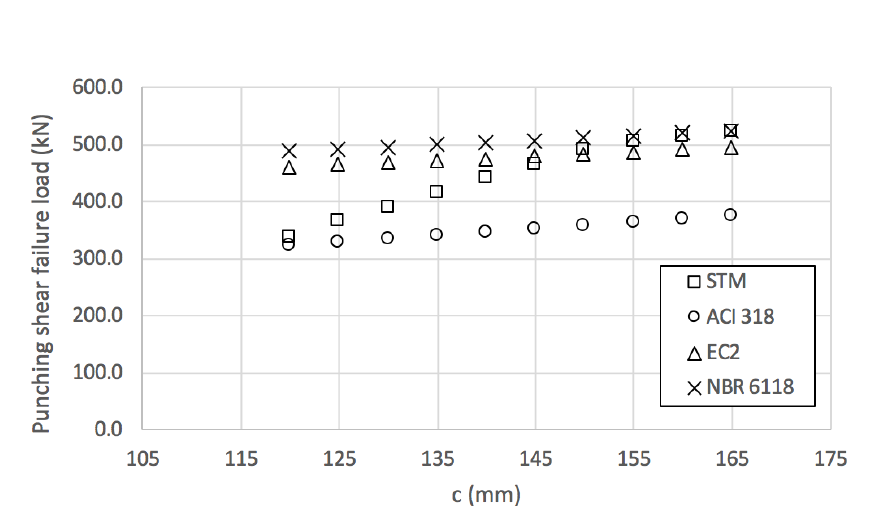
Figure 9. Support dimension versus punching shear resistance - Group C